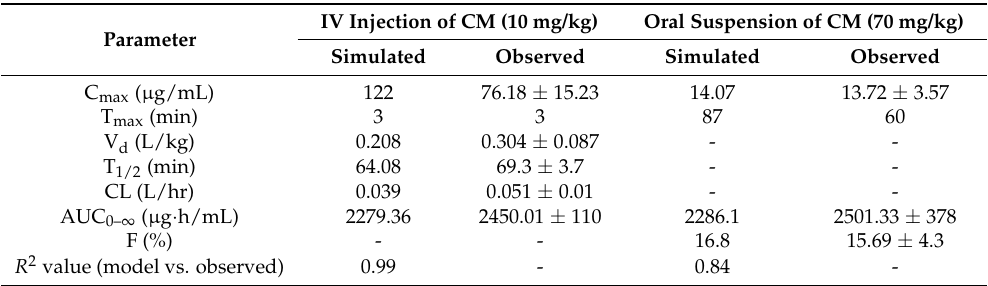
Table 1. Comparison between predicted CM pharmacokinetic parameters and observed values following iv and oral dose of CM.